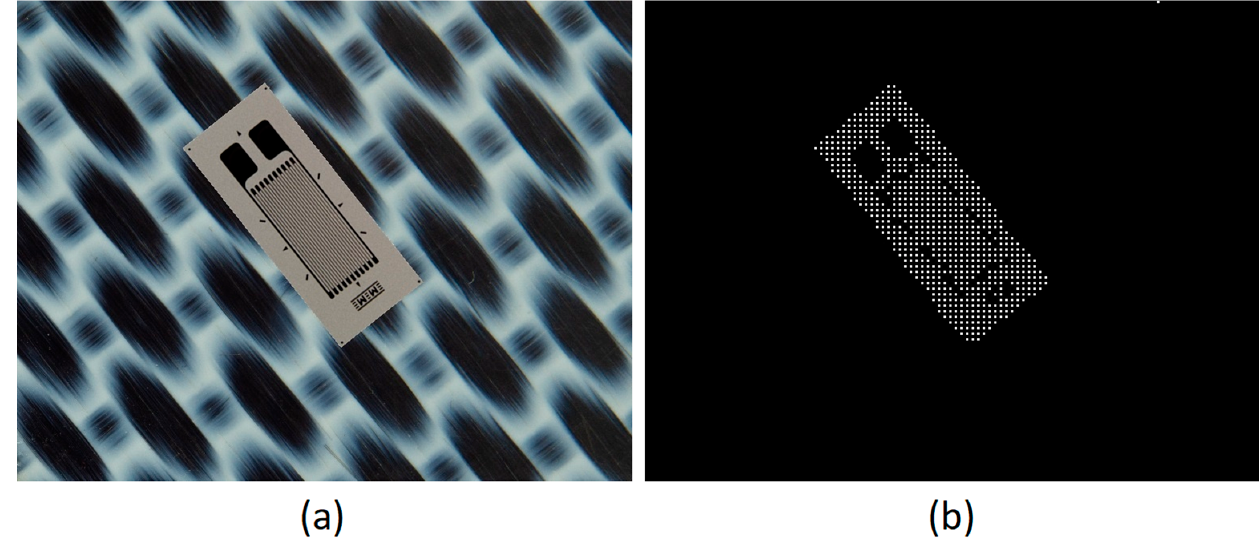
Figure 2. Acquired image ( a ) and output ( b ) from step 1 processing.